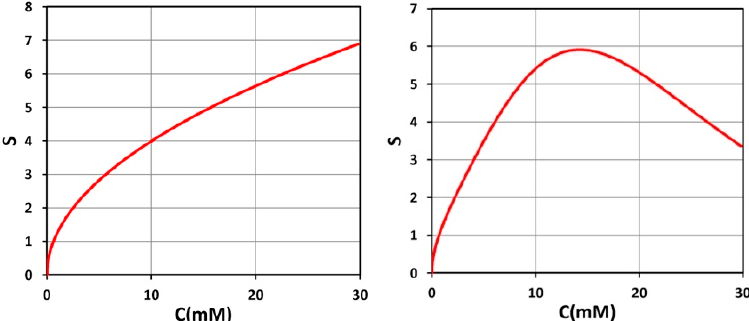
Figure 5. Spatial profiles of S for various exposure time t = (100, 200, 300, 400) s shown by (green, red, blue, purple) curve, for fixed light intensity I 0 = 10 (mW/cm 2 ) and C 0 = 2 mM, for D = 1.0 cm ( left figure ) and D = 10 cm ( right figure ).